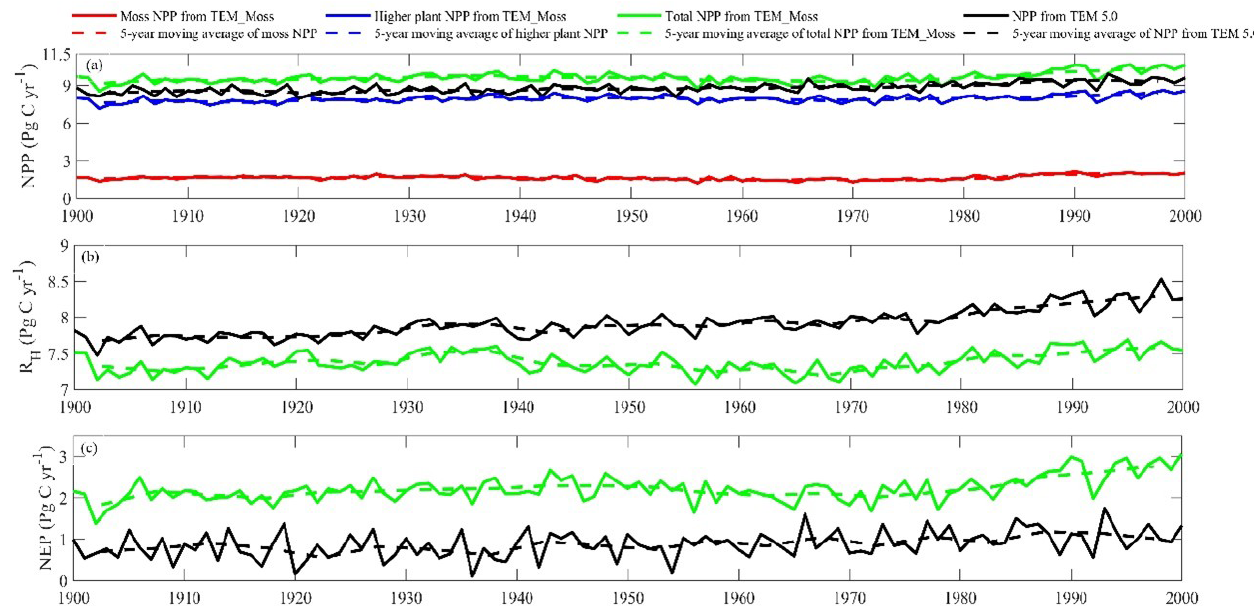
Figure 9. Simulated annual net primary production (NPP, a ), heterotrophic respiration ( R H , b ), and net ecosystem production (NEP, c ) during the 20th century by TEM_Moss and TEM 5.0.